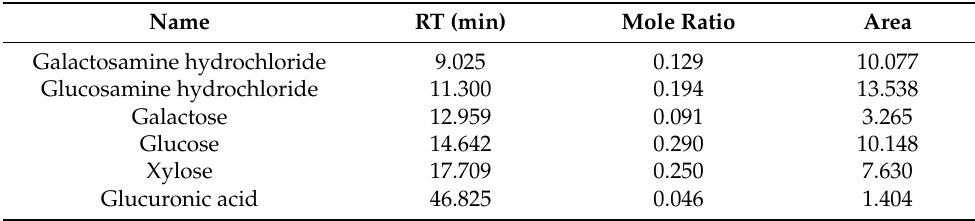
Table 2. Analysis of monosaccharide composition of PW-7 EPS.